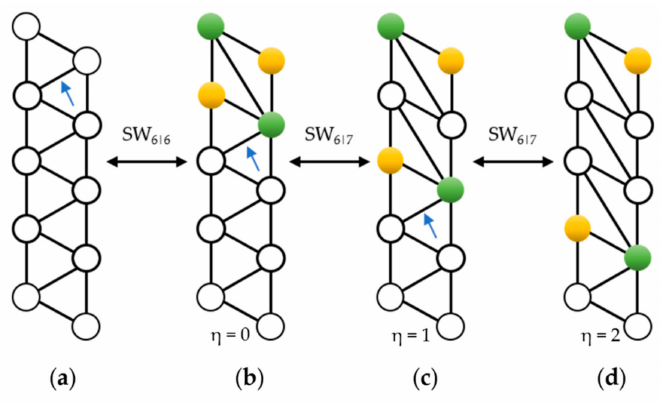
Figure 2. ( a ) SW 6 | 6 rotation of the arrowed bond creates in the pristine graphene dual lattice (white circles represent dual hexagons) the 5 | 7 double pair on the left. ( b ) A view of the 5 | 7 double pair; SW 6 | 7 applied to the arrowed bond moves one 5 | 7 pair one step down in the hexagonal mesh ( c ). After the second iterated SW 6 | 7 rotation SWw of order η = 2 is formed ( d ). Green (yellow) elements represent heptagonal (pentagonal) rings. The 5 | 7 double pair in ( b ) represents SWw of order η = 0. All Stone–Wales rearrangements are